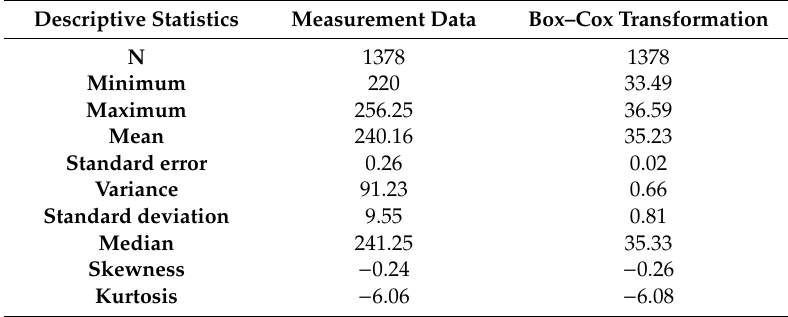
Table 1. Selected descriptive statistics for the Krzemionki mining area and its surroundings.